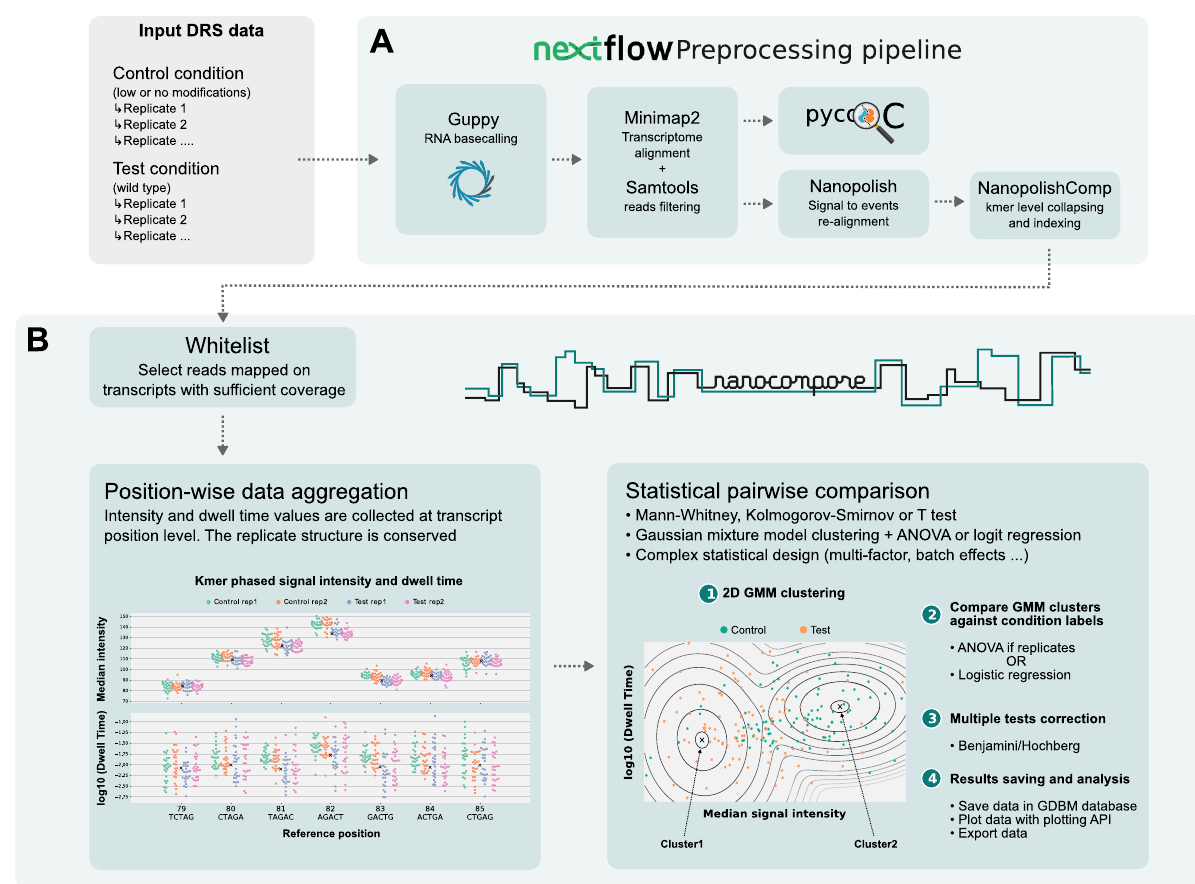
Fig. 1 Overview of data preparation and Nanocompore steps. A Raw fast5 reads from 2 conditions are basecalled with Guppy, fi ltered with Samtools and the signal is then resquiggled with Nanopolish eventalign. The output of Nanopolish is then collapsed and indexed at the kmer level by NanopolishComp Eventalign_collapse. B Nanocompore aggregates median intensity and dwell time at transcript position level. The data is compared in a pairwise fashion position per position using univariate tests (KS, MW, t-tests) and/or a bivariate GMM classi fi cation method. The p-values are corrected for multiple tests and these data are saved in a database for further analyses. The signal graph is as an illustration not representative of all possible